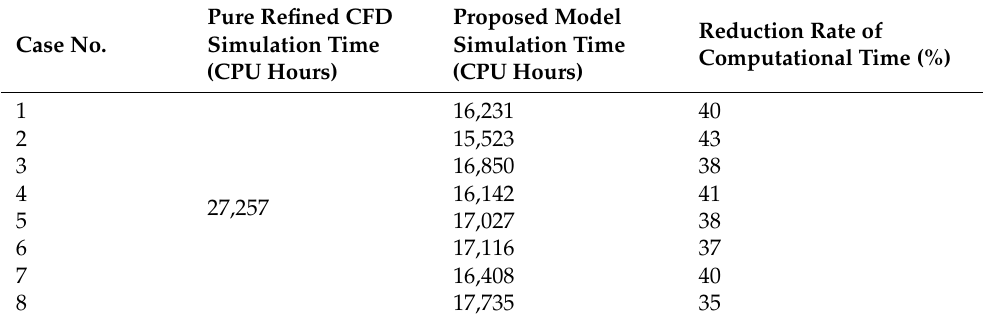
Table 9. Comparison of the computational time for pure refined CFD and the proposed model (5 training data points).